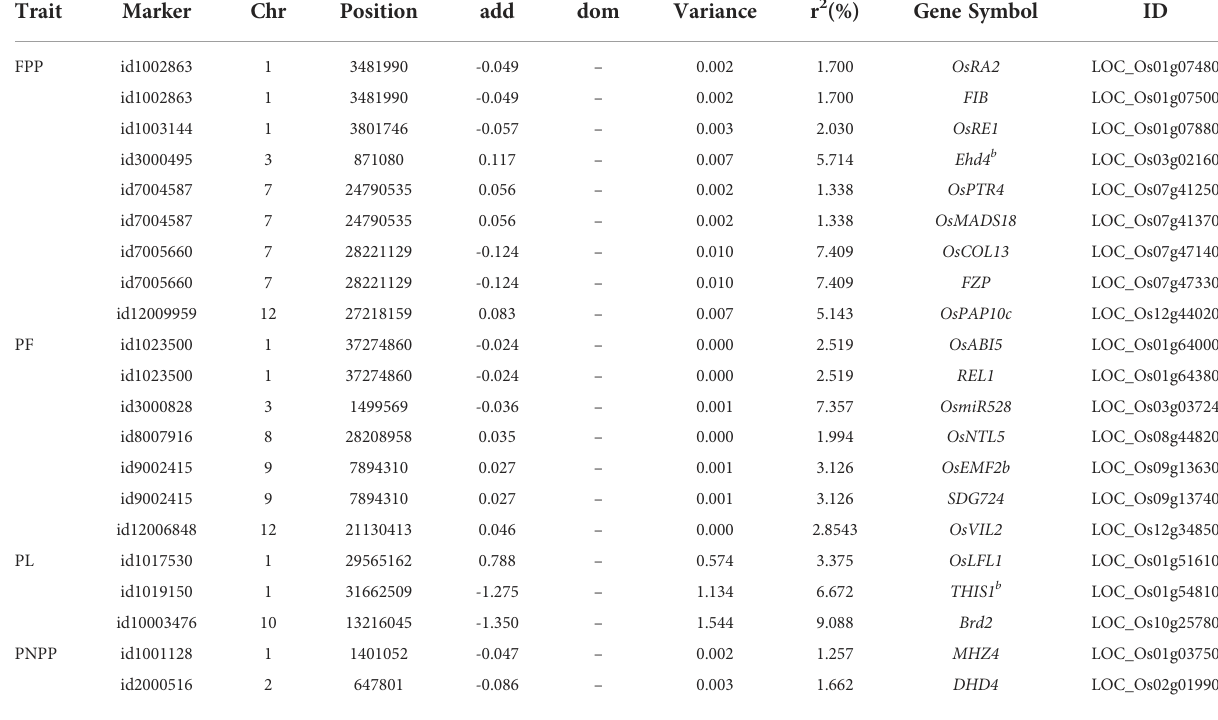
TABLE 2 Known genes identi fi ed for rice yield-related traits using the QTN detection model in 3VmrMLM.